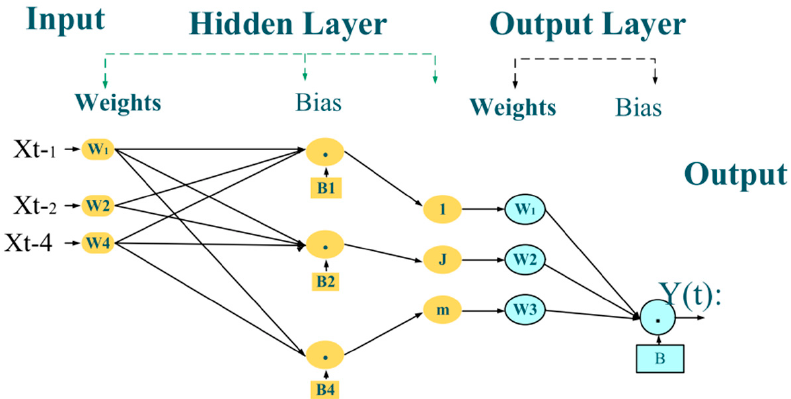
Figure 6. FFBP neural network topology.